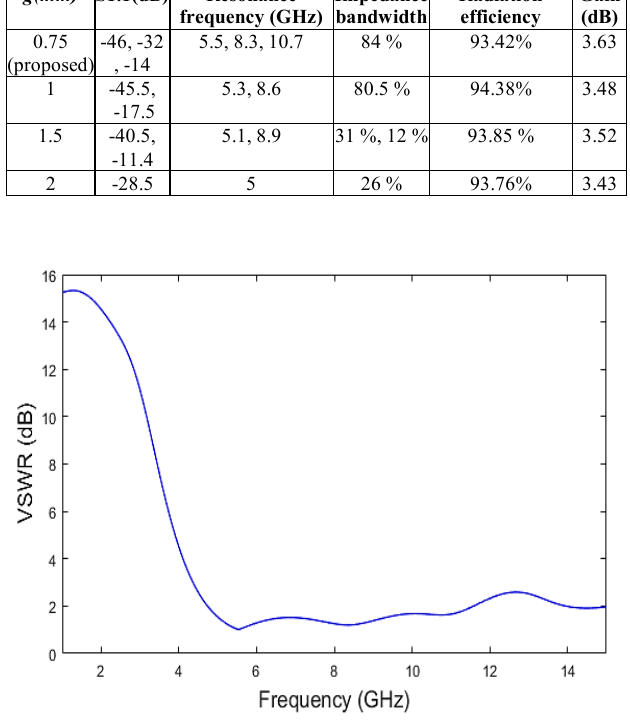
Figure 7: Simulated VSWR of model 4